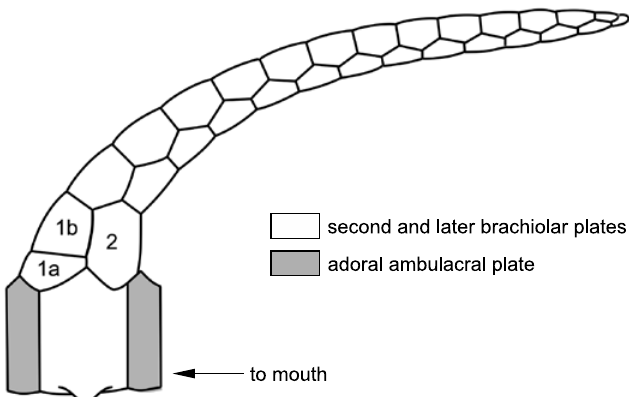
Fig. 15. Brachiole and main ambulacral plating in hemicosmitoid Caryo­ crinites ornatus Say, 1825, Wenlock (Silurian), New York, USA. The ambu- lacra are erect. Each brachiole arises from a pair of main ambulacral plates, the adoral of which are shaded. The aboral plates are more than twice as wide. The first brachiolar plate (1a) is adoral to the second (2) and supports the idea that main ambulacral plates are first brachiolar plates modified to form the ambulacral axis. Redrawn from Sprinkle 1975: 1067, fig.